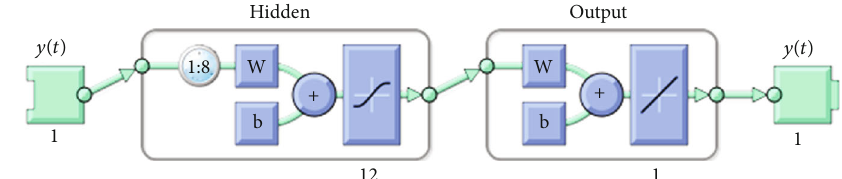
Figure 3: Architecture of the NARNET model.